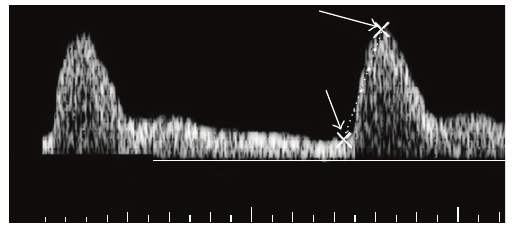
Figure 1: Pulsed-waveform of a supratesticular artery illustrating measurement of peak systolic velocity (right arrow) and end dias- tolic velocity (left arrow).